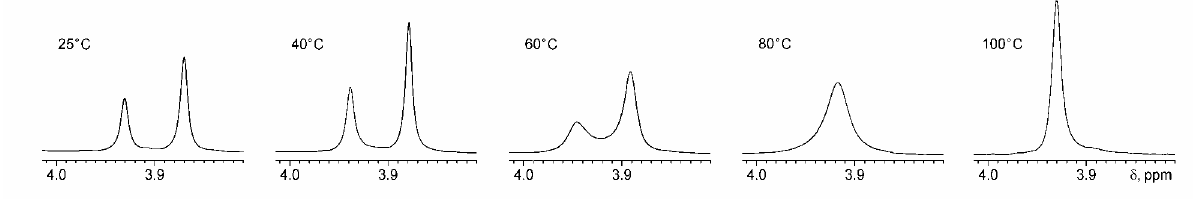
) spectra for H-17a/b of compound 3 6